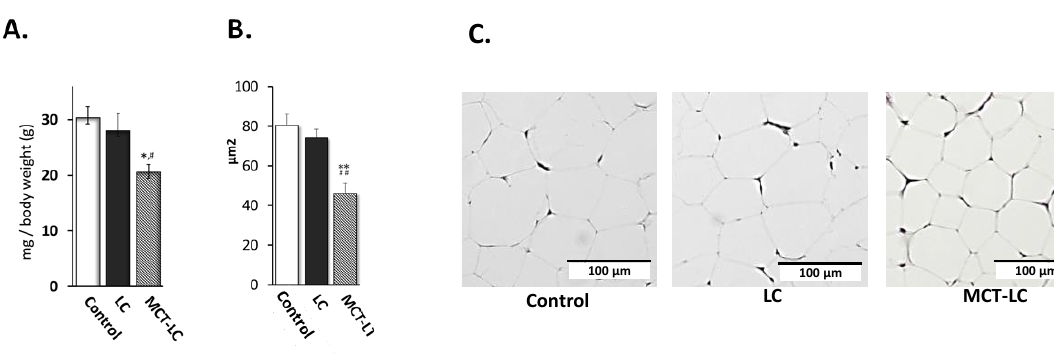
Figure 2. Weights (per gram of body weight) ( A ), adipocyte area ( B ), and hematoxylin-eosin (HE) staining ( C ) of epididymal adipose tissues in the three diet groups. Data shown are mean ± SEM. Control, control diet; LC, low-carbohydrate diet high in lard; MCT-LC, low-carbohydrate diet high